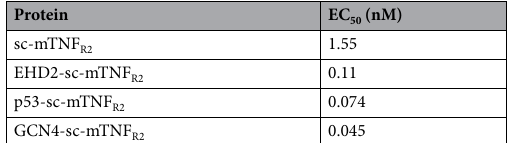
Table 1. Overview of the EC 50 values (nM) binding